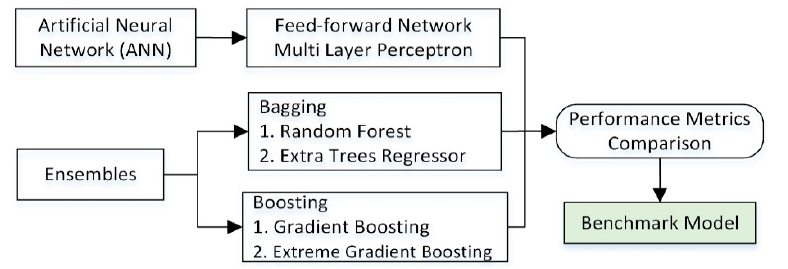
Figure 9. Benchmark selection using ANN and Ensemble models. Figure 9 . Benchmark selection using ANN and Ensemble models. Figure 9 . Benchmark selection using ANN and Ensemble models.